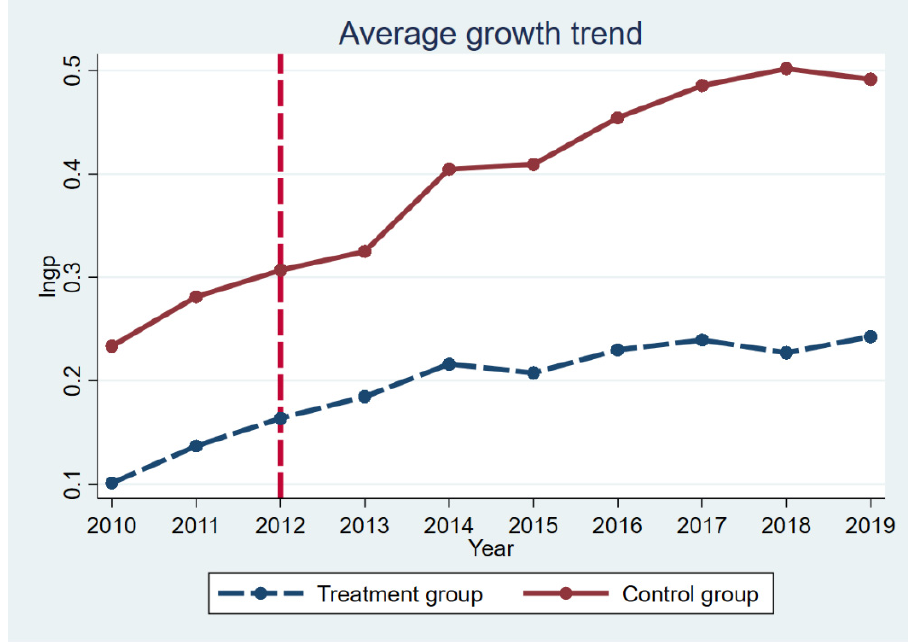
Figure 2. Parallel trend